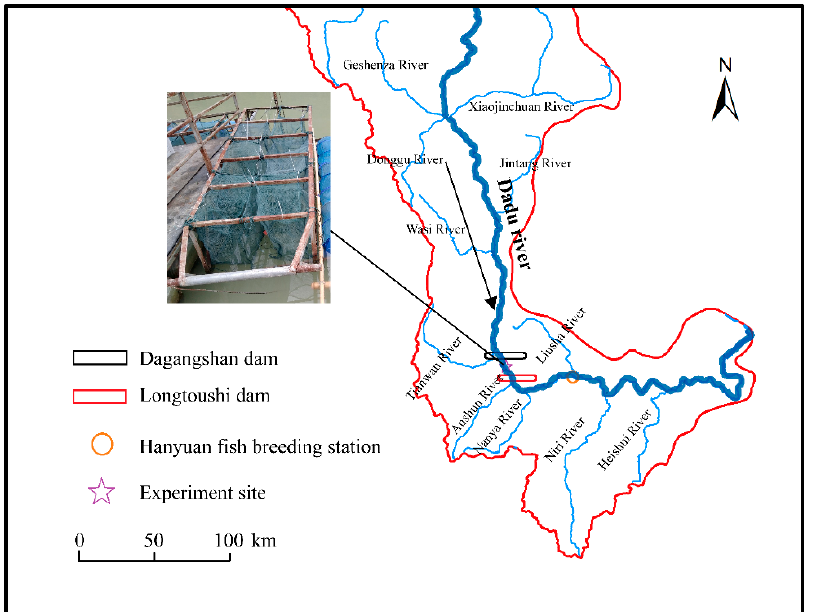
Figure 1. The Dadu river system, showing the positions of the Dagangshan dam, experiment site, Longtoushi dam and Hanyuan fish breeding station; the arrow indicates the direction of river flow.